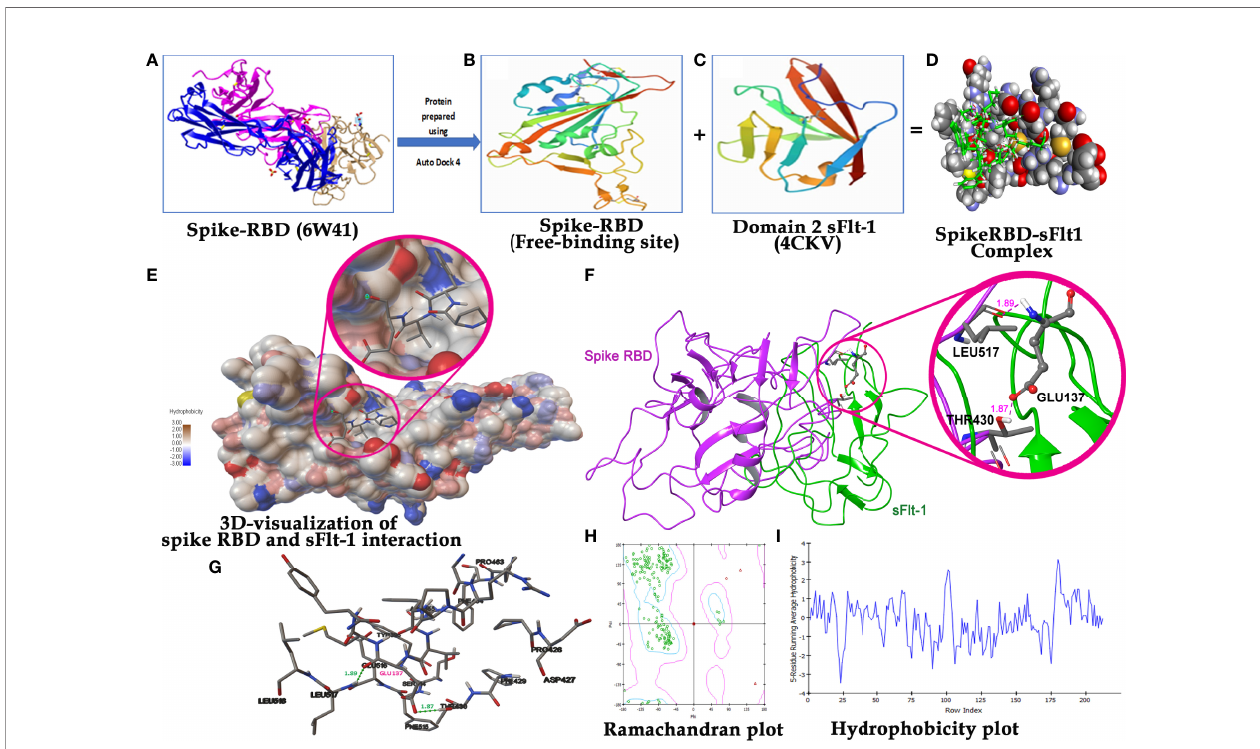
FIGURE 2 | Molecular Docking analysis demonstration binding of sFlt-1 to spike RBD: (A) 3D structure of spike RBD retrieved from PDB (6W41) and prepared for docking. (B) Spike RBD 3D-structure (333-525 amino acid residues) after deleting extra chains. (C) 3D structure of domain 2 sFlt-1 retrieved from PDB (4CKV) and prepared for docking (132-225 amino acid residues) as a ligand. (D) Spike RBD -sFlt-1 complex as a result of autodock run analysis. (E) 3D visualization of spike RBD and sFlt-1 interaction with close view showing the binding of sFlt-1 amino acid residues in the active site groove of spike RBD. hydrophobicity scale represents colours (hydrophilic to hydrophobic) shown in the active site of spike RBD. (F) Ribbon representation of spike RBD and sFlt-1 interaction showing the binding of Glu137 of sFlt-1 with Leu517 and Thr430 of spike RBD by two hydrogen bonds. (G) 2D-visualization of the protein-protein interaction showing the amino acids involved in this binding. (H) Ramachandran plot demonstrating the plot of the torsional angles - phi ( j ) and psi ( y ) - of the amino acid residues contained in a protein. plotting the j values on the x-axis and the y values on the y-axis shows which combination of angles is possible. The torsional angles of each residue in a peptide determine the conformation of the residues and the protein. (I) Hydrophobicity plot: Indicates the amino acids in a complex protein against their hydrophobicity index, residues with hydrophobicity of 0.7 or more are considered hydrophobic and those under -2.4 are